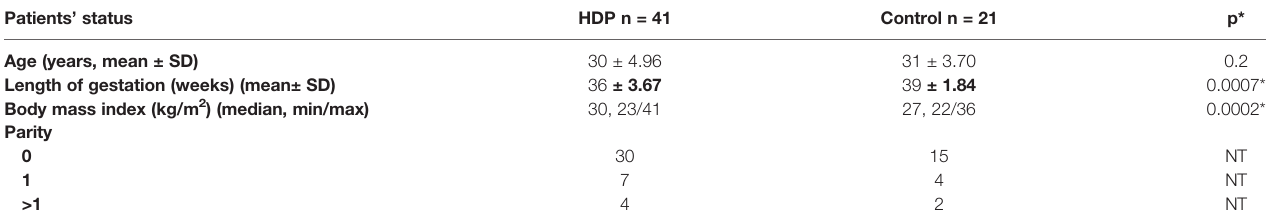
TABLE 1 | Patient ’ s